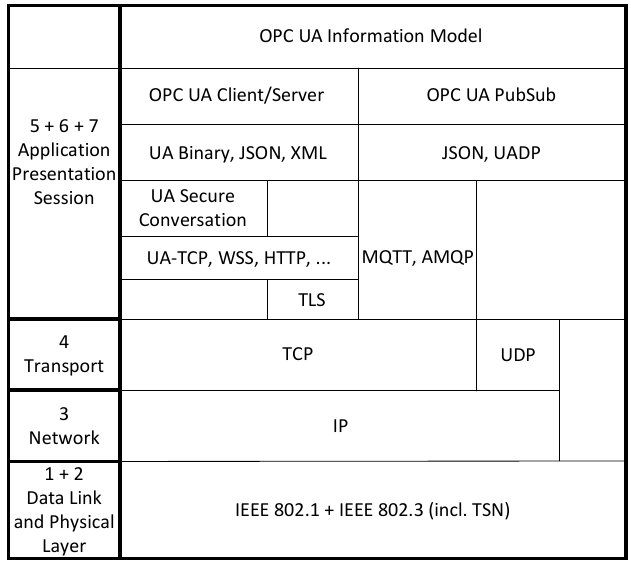
Figure 4. OPC UA in the Open Systems Interconnection (OSI) reference